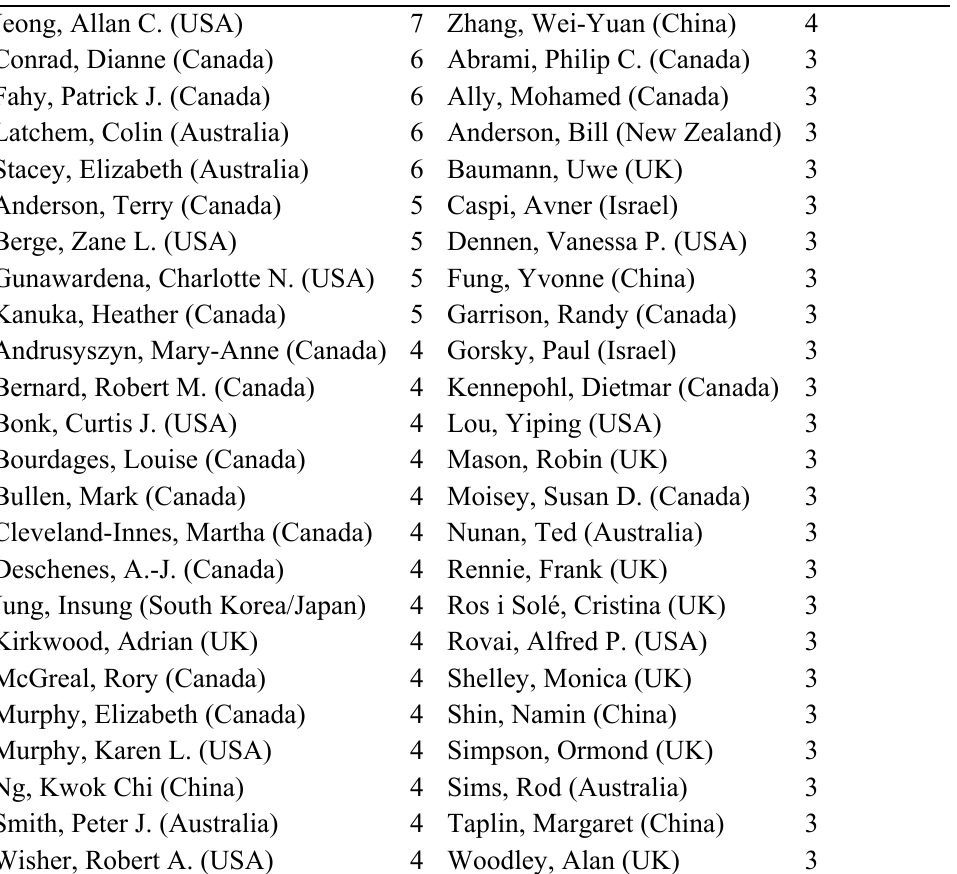
Leading Contributors and Number of their Published